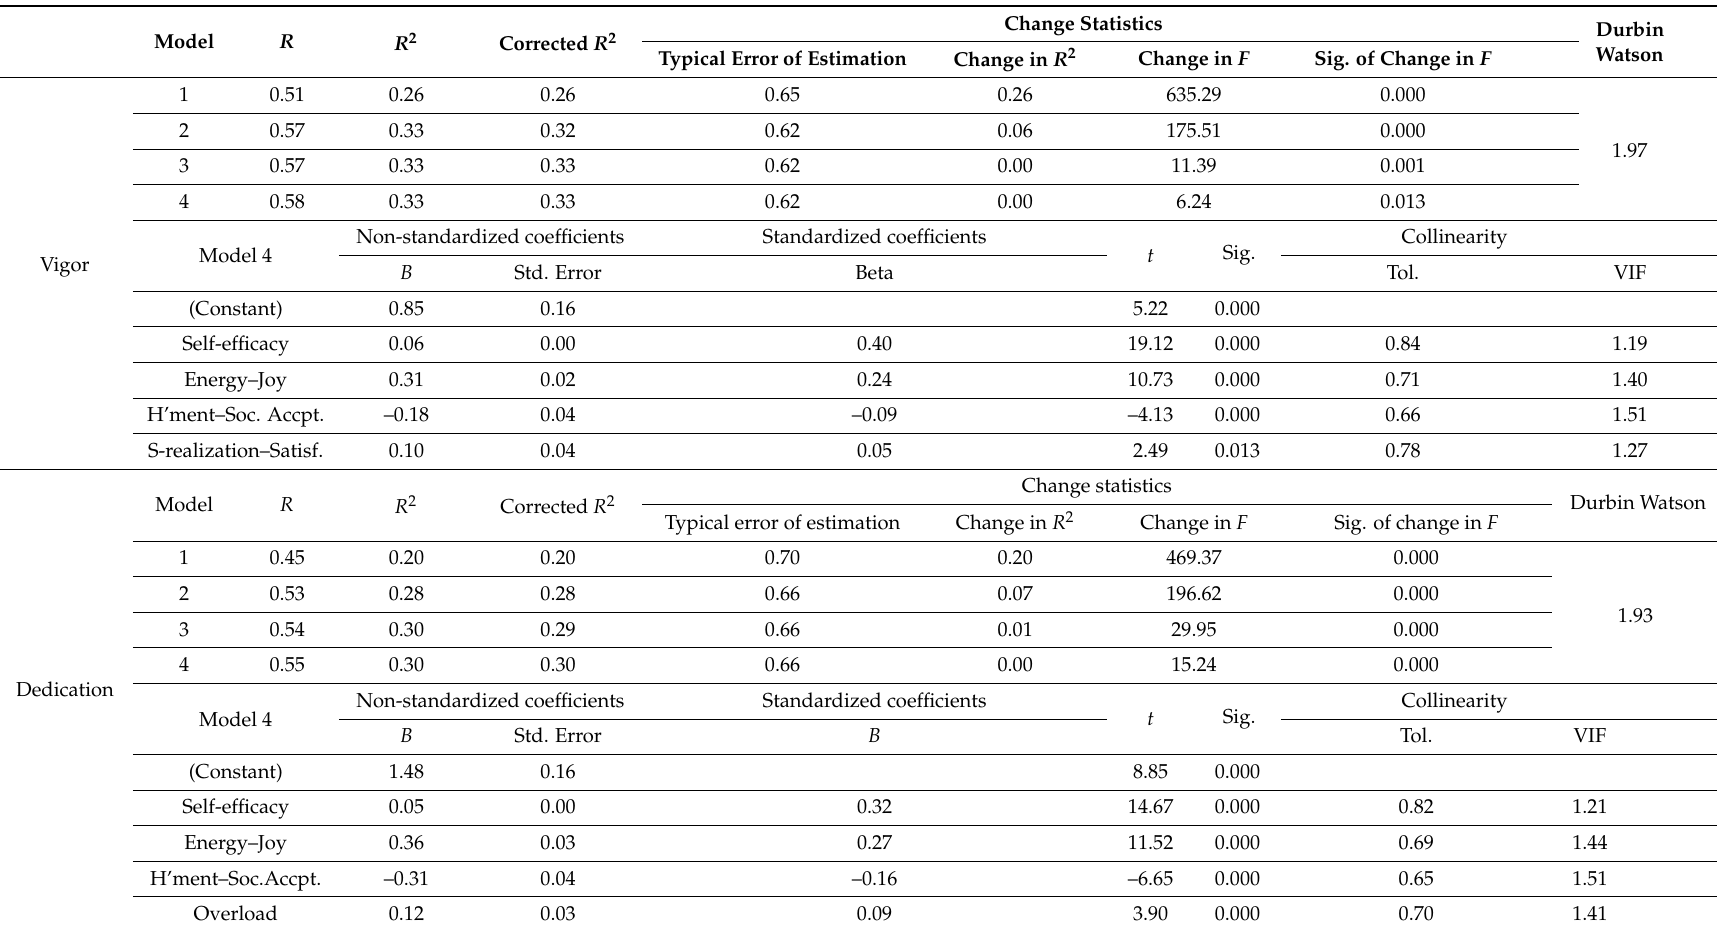
Table 2. Engagement dimensions. Stepwise multiple linear regression model ( N =